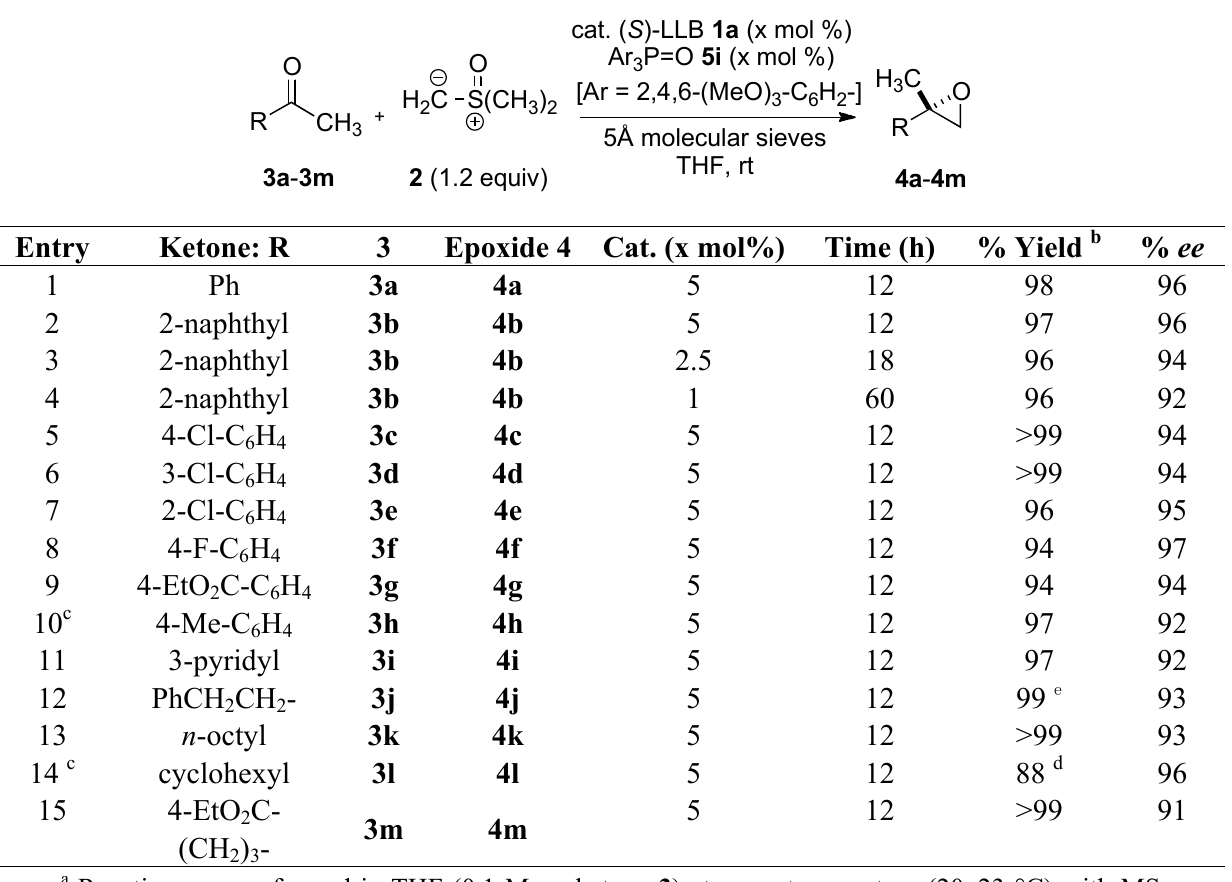
Table 2. Catalytic asymmetric synthesis of 2,2-disubstituted terminal epoxides from various methyl ketones a